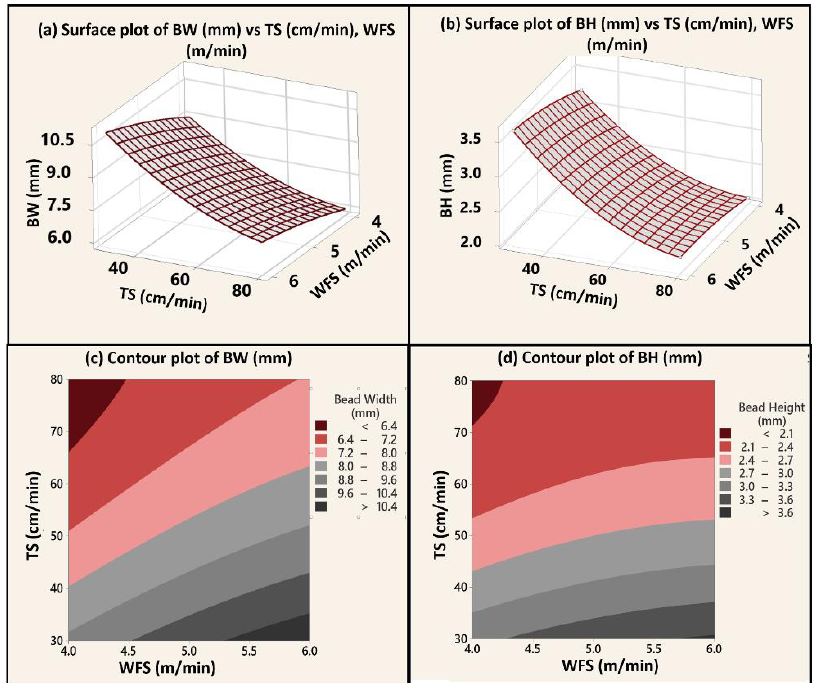
Figure 10. The ( a , b ) surface plots and ( c , d ) contour plots for BW and BH with respect to significant process variables.